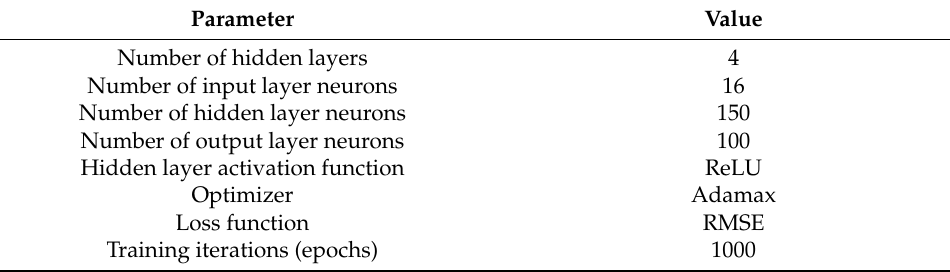
Table 4. Input features of each model.